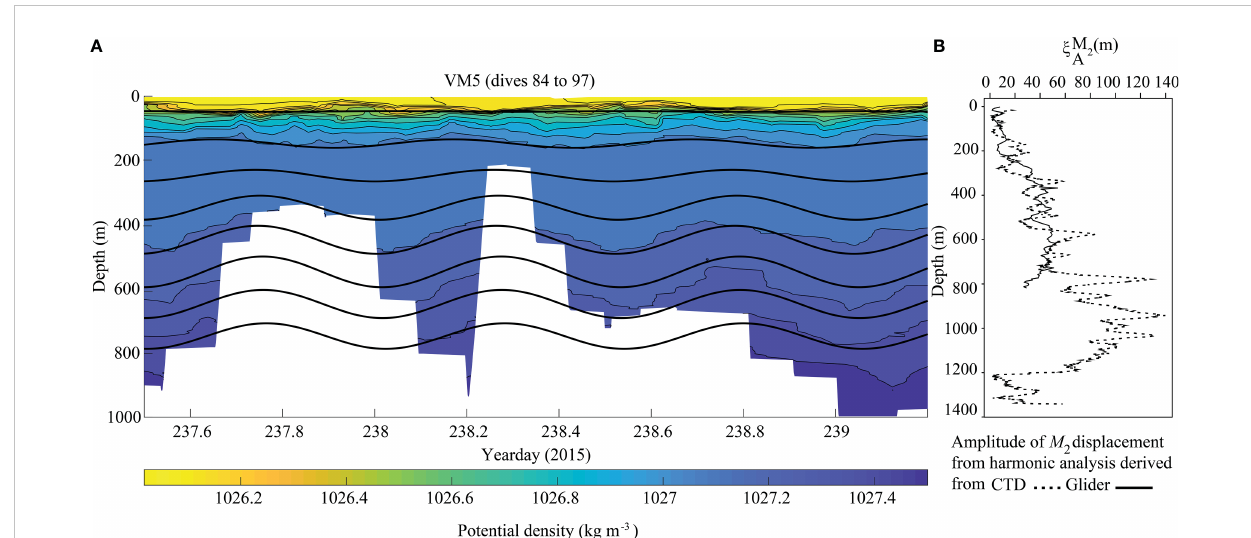
FIGURE 3 Time series of potential density overlaid with M 2 harmonically fi ltered vertical isopycnal displacement every 100 m calculated from (A) VM5. When operating in virtual mooring mode the glider stayed within 2.5 km of the station, but this imperfect geolocation over the steep canyon bathymetry resulted in a range of dive depths (white background). (B) Amplitude of M 2 displacement from the harmonic analysis derived from CTD (dashed lines) and glider data (Solid